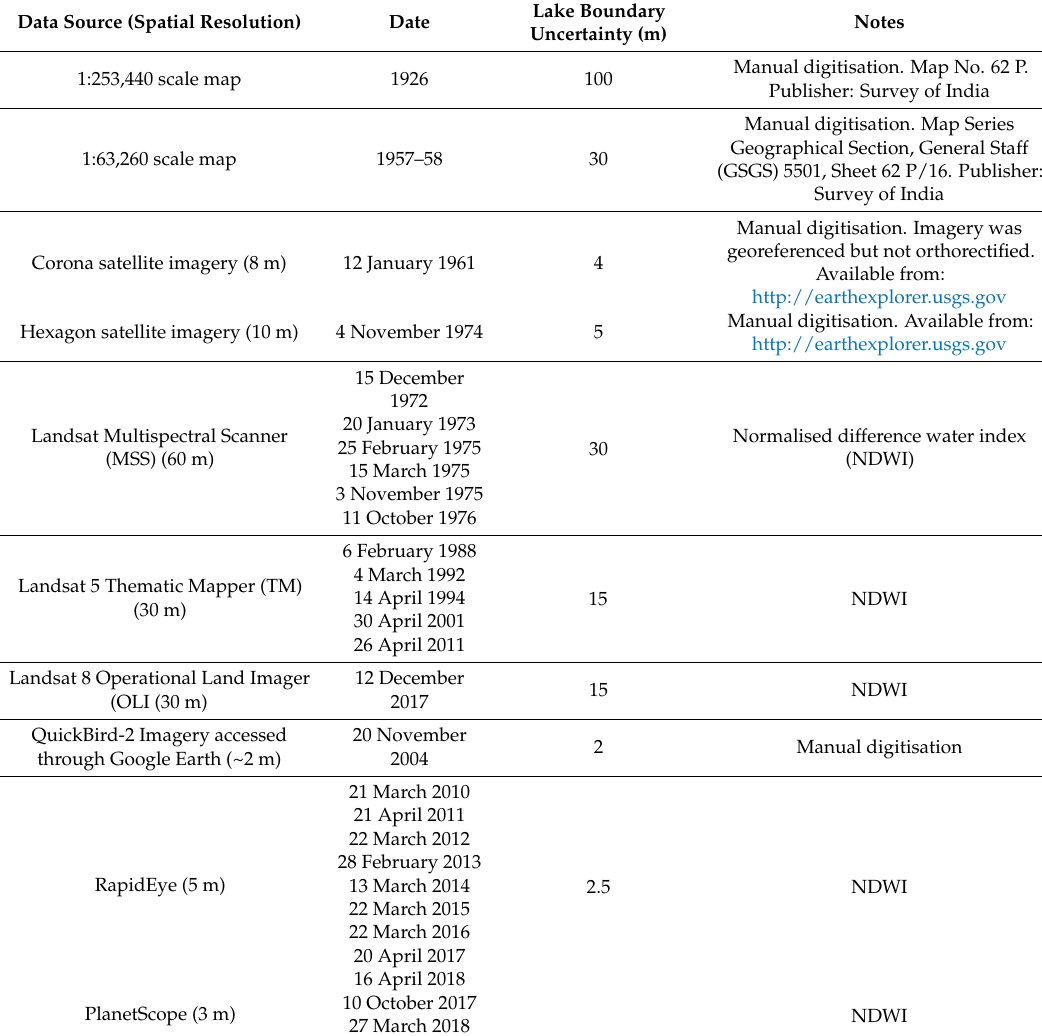
Table 1. Historical maps and satellite imagery used to derive the area of Phewa Lake.